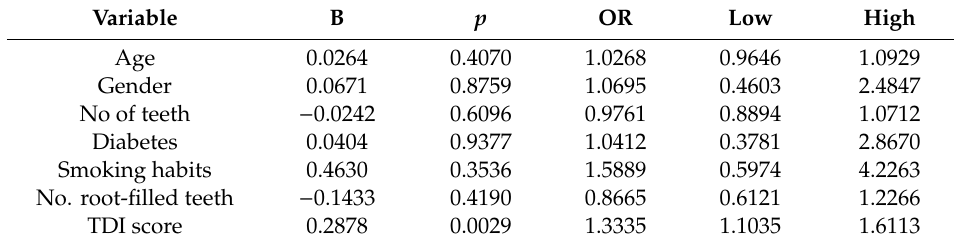
Table 6. Multivariate logistic regression analysis of the influence of the independent variables age, gender (0 = women, 1 = male), number of teeth, diabetes (0 = absent, 1 = present), smoking habits (0 = non-smoker, 1 = smoker), number of root-filled teeth, and TDI score on the dependent variable “metabolic syndrome” (0 = absent, 1 =